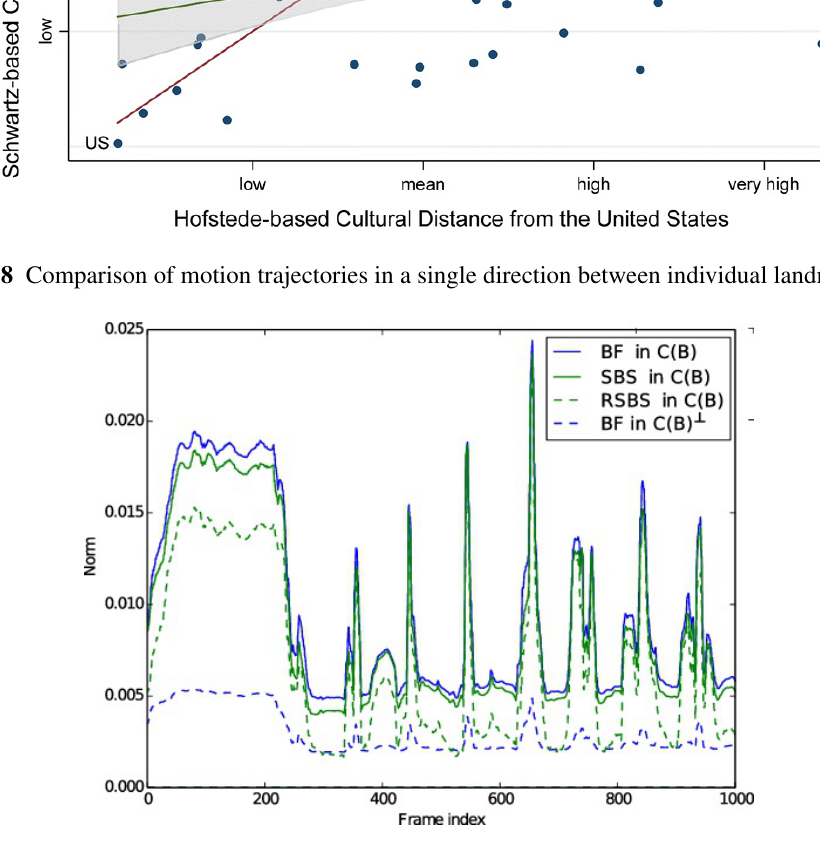
Fig. 9 Marker data based on Euclidean